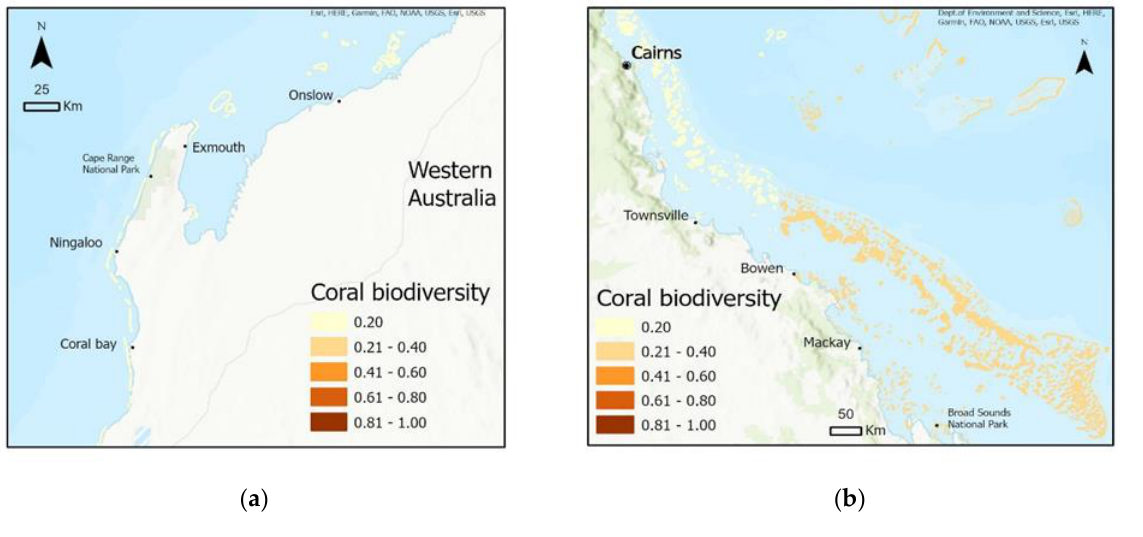
Figure 5. Exposure indicator maps of coral biodiversity in the Ningaloo Reef ( a ) and the southern Great Barrier Reef ( b ). Higher (darker) values denote a higher number of coral species.